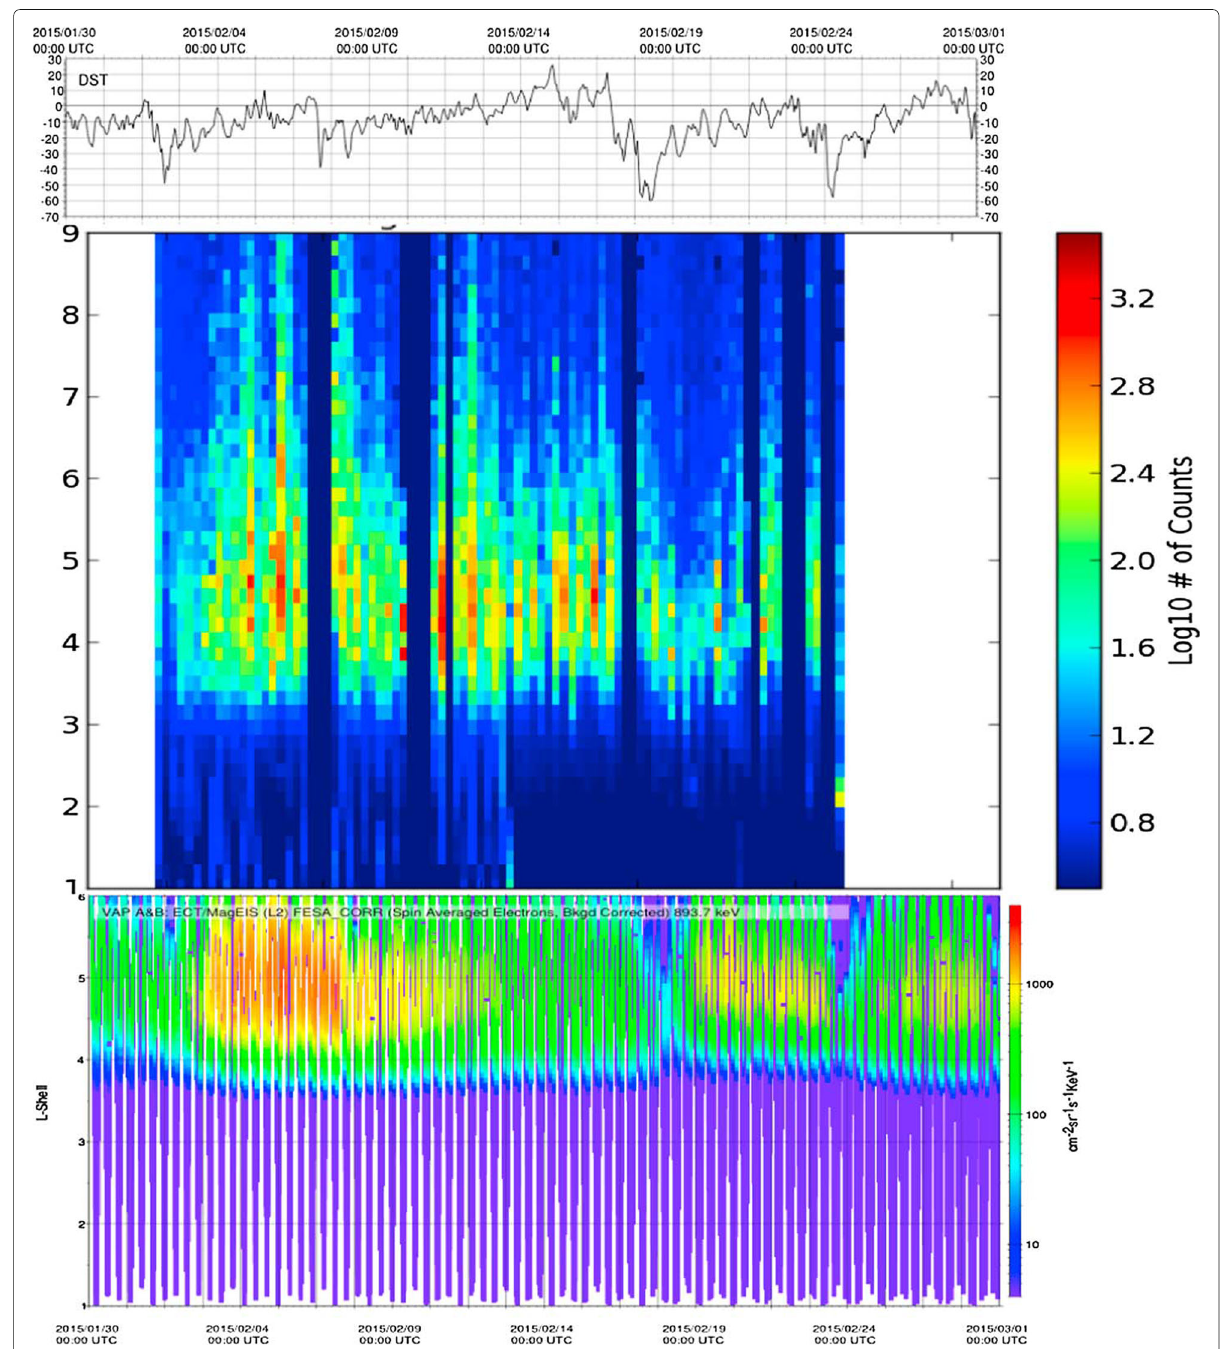
Fig. 7 Measurements of > 985 keV electrons by sensors onboard FireBird and differential flux by MagEIS for the 893 keV channel (reproduced from Crew et al. (2016). The top panel shows the Dst index, the middle panel FIREBIRD-integral counts, and the bottom panel MagEIS